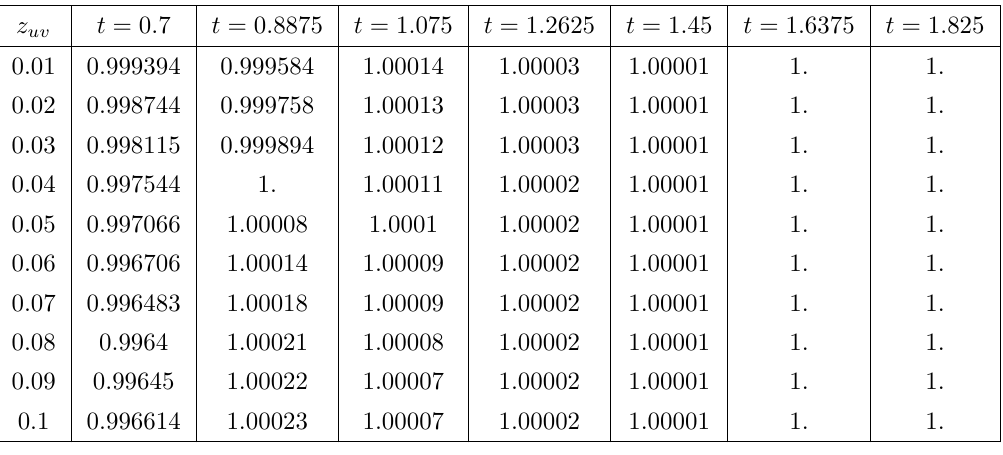
Table 11 . We vary our cuto(cid:11) from .01 to .1 and (cid:12)nd stable results of the correlation functions on the order of 10 (cid:0) 5 . These values were calculated for 2-point correlation functions of an (uncharged) scalar operator in a neutral thermalizing (cid:13)uid (dual to the evolution towards a Schwarzschild black brane geometry), (cid:26) = 0 : 0, B = 0 : 0 and boundary conditions l = 0 : 7. Our numerical background geometry was computed with a grid size of 150 points in the radial direction and a grid size of 250 points for our non-a(cid:14)ne parameter.